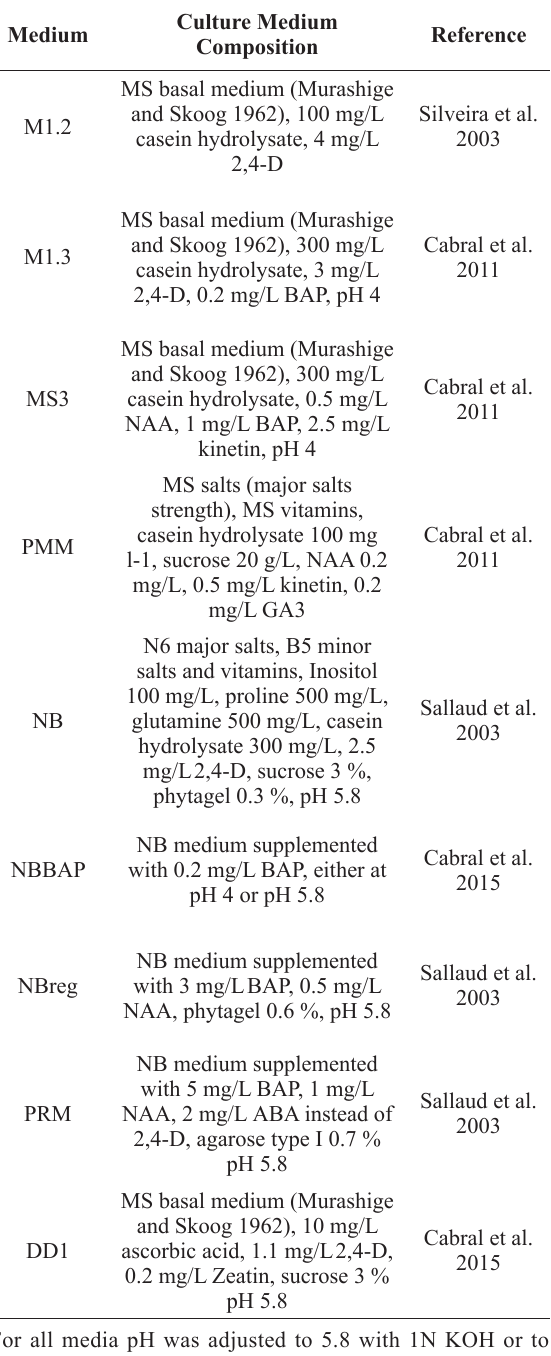
Culture media used for B. brizantha somatic embryogenesis induction, plant regeneration and